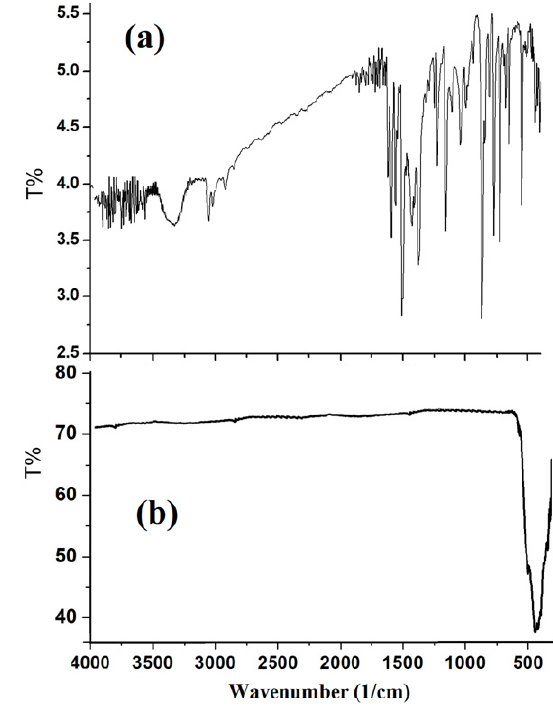
Figure 2. IR-KBr disk spectra ( a ) desired complex; and ( b ) NiO